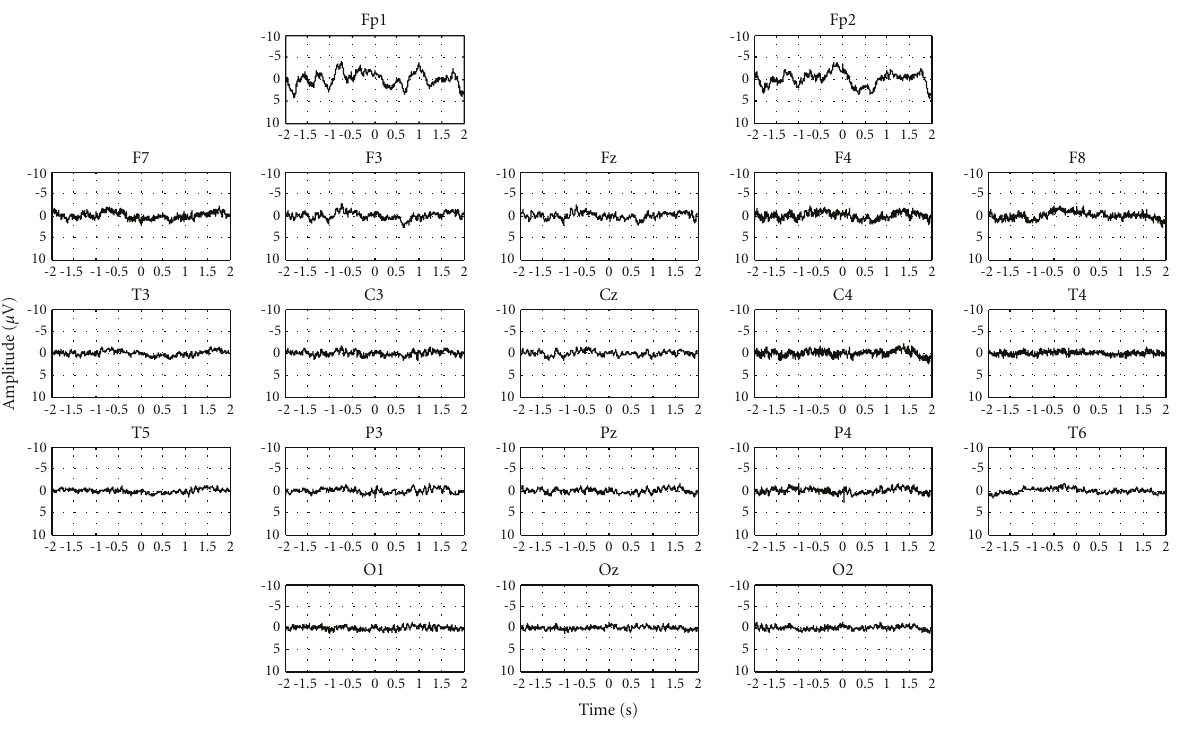
Figure 2: Grand Average topographic distribution of ERPs from spontaneous EEG, with unlighted LEDs.